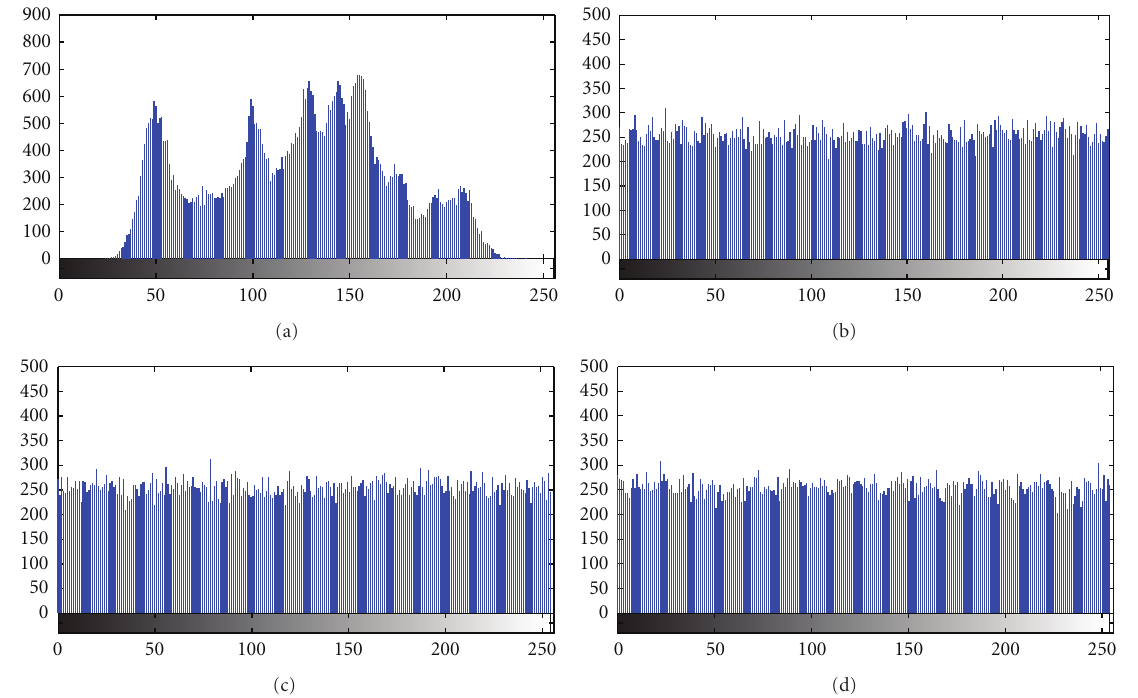
Figure 2: Result of histogram analysis. (a) Histogram of the original image, (b) the described algorithm, (c) A5/1 algorithm, and (d) W7 algorithm.